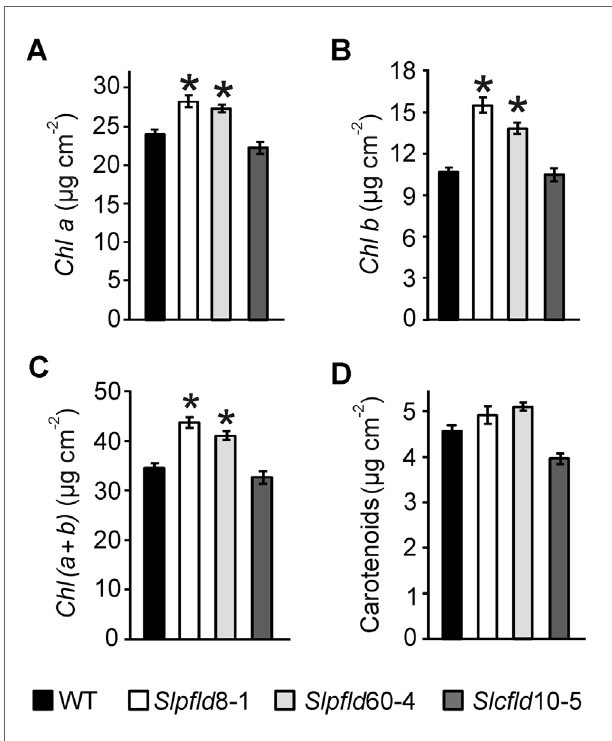
FIgURE 2 | Tomato leaves expressing flavodoxin in chloroplasts displayed higher chlorophyll content. (A) Chlorophyll ( Chl ) a , (B) Chl b , (C) Chl (a+b) , and (D) carotenoids were determined in the third leaflet of the fourth fully expanded leaf of plants at 64 days post-germination. Data shown are means ± SEM of six biological replicates. Statistical differences between wild-type and transgenic lines are indicated by asterisks and were determined using one-way ANOVA and Tukey's Multiple Comparison Test ( P <